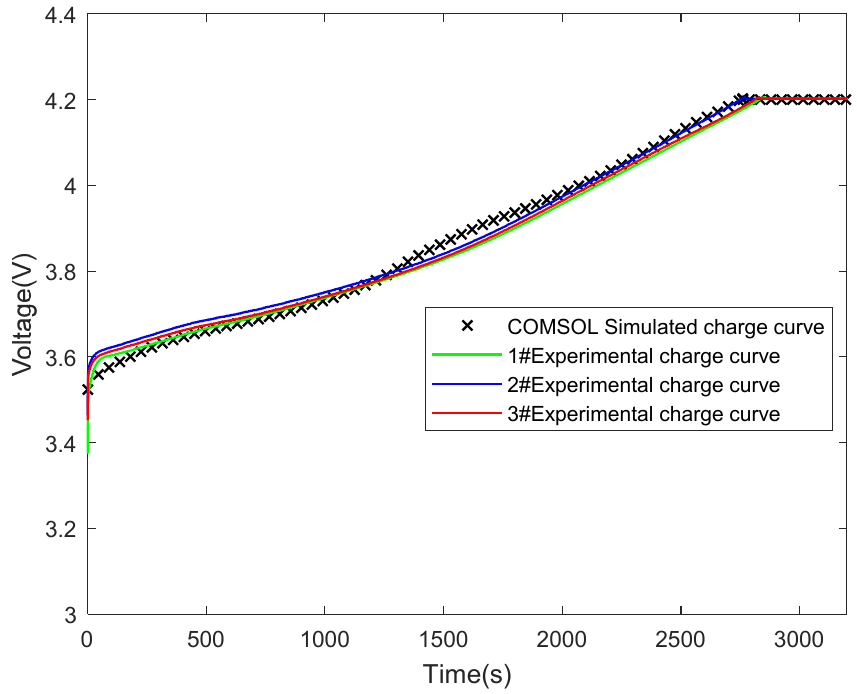
Figure 3. Comparison of simulated and measured battery voltage curves.